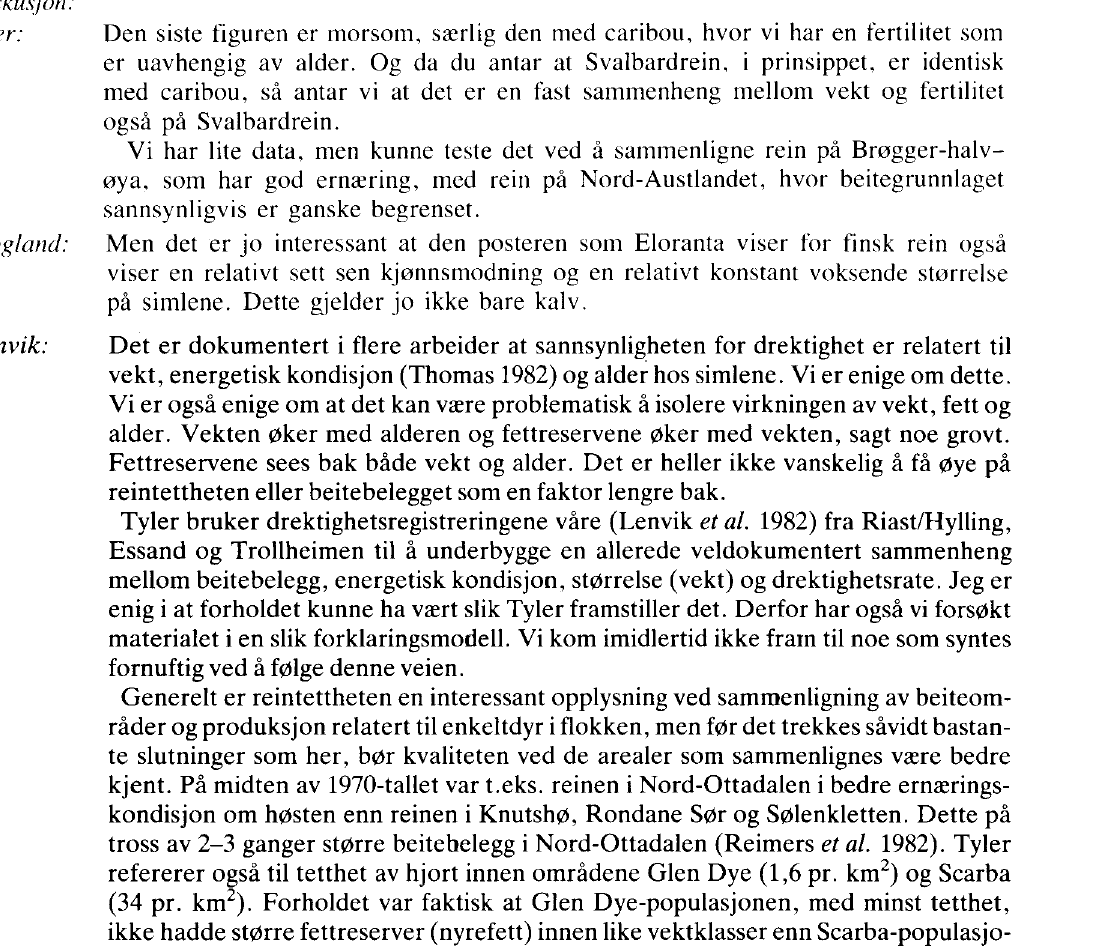
Den siste figuren er morsom, særlig den med caribou, hvor vi har en fertilitet som er uavhengig av alder. Og da du antar at Svalbardrein, i prinsippet, er identisk med caribou, så antar vi at det er en fast sammenheng mellom vekt og fertilitet også på Svalbardrein. Vi har lite data, men kunne teste det ved å sammenligne rein på Brøgger-halv- sannsynligvis er ganske